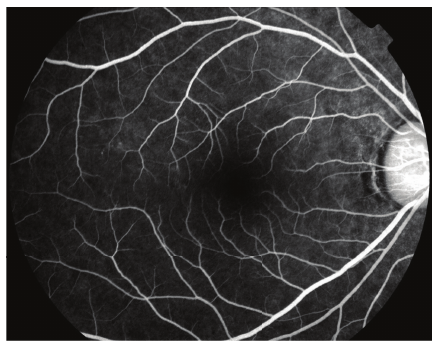
Figure 3: Fluorescein angiography (right eye).